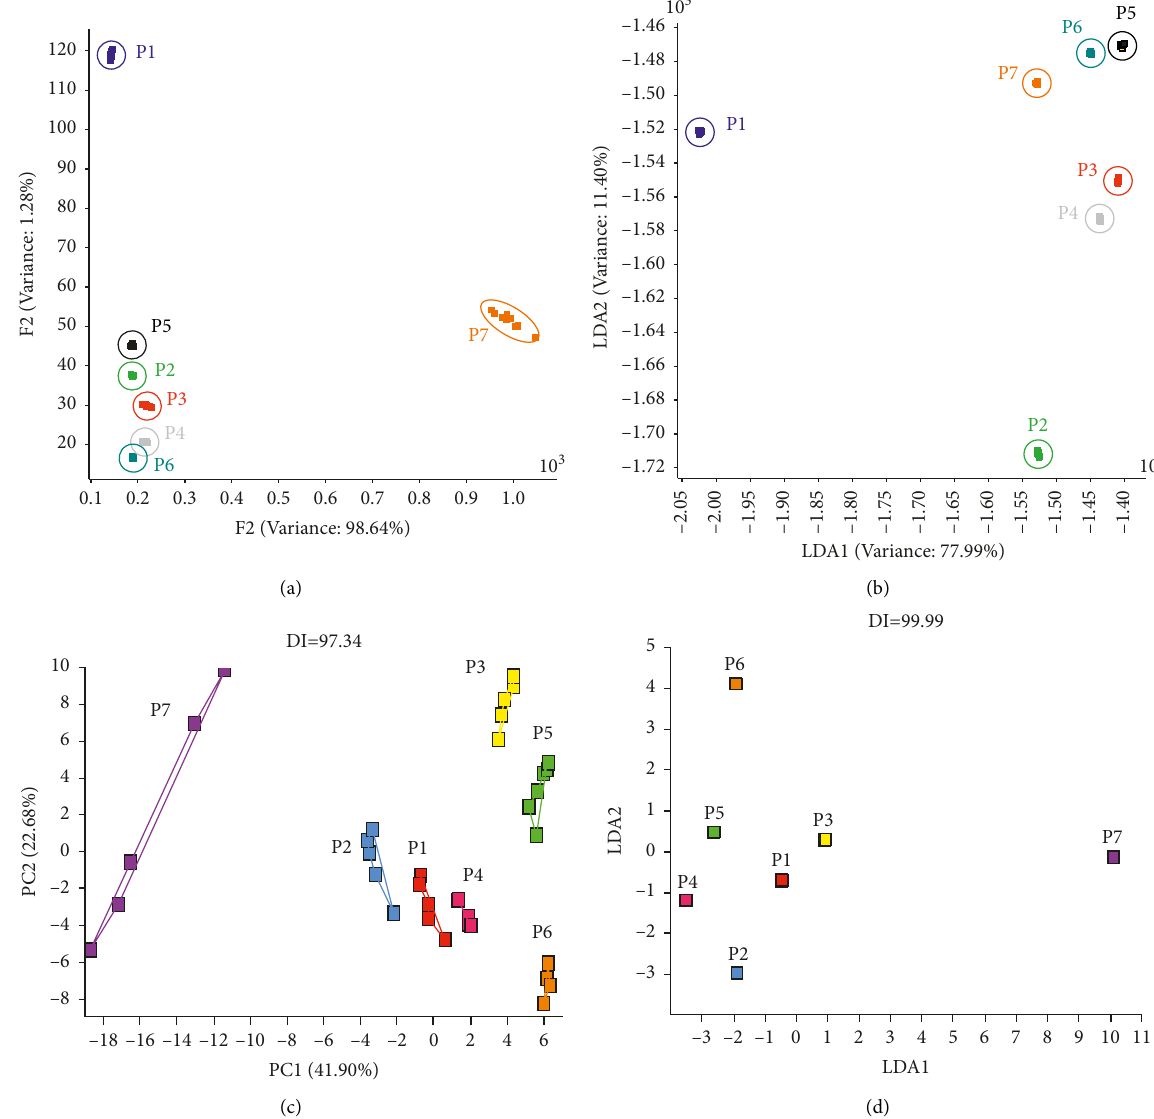
Figure 3: Visualization of beer samples’ distribution based on e-nose and e-tongue determination. (a) Score plot of principal component analysis (PCA) performed on beers using the e-nose. (b) Score plot of linear discriminant analysis (LDA) performed on beers using the e- nose. (c) Score plot of PCA performed on beers using the e-tongue. (d) Score plot of LDA performed on beers using the